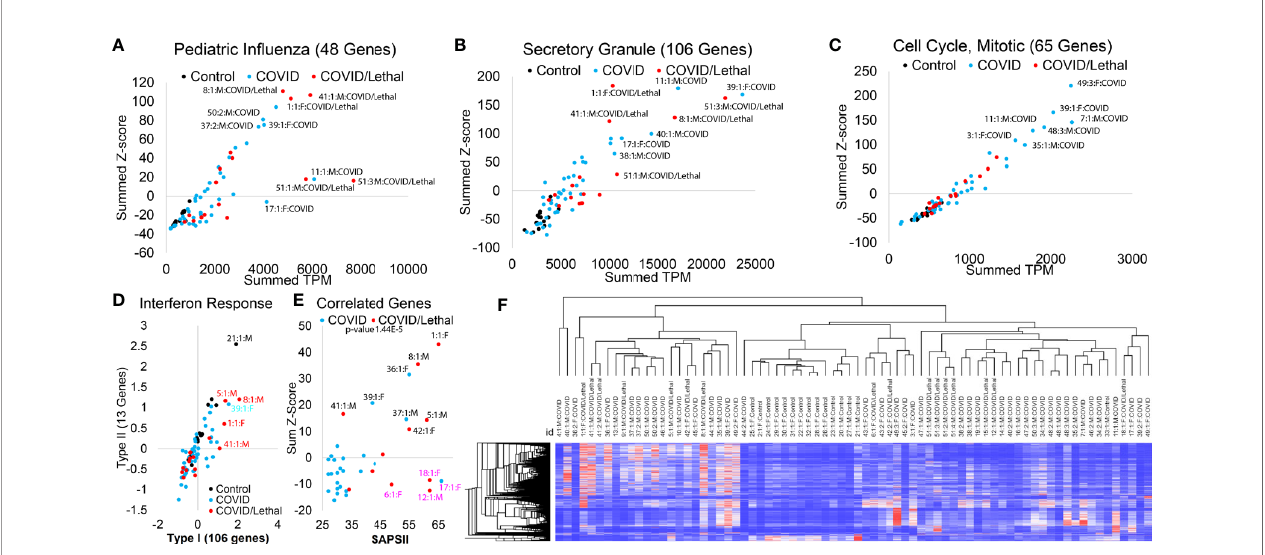
FIGURE 4 | Blood transcriptome gene panel signatures of SARS-CoV-2 patients. (A – C) Enriched associated genes for severe pediatric in fl uenza (A) , secretory granule (B) , and mitotic cell cycle (C) . The x-axis shows the added transcript per million (TPM) of all genes in the gene list, and the y-axis shows the added z-score for each group ’ s genes. Control samples are shown in black, COVID-19 patients in cyan, and COVID-19 patients deceased in red. The outlier samples are labeled (Sample #:collection #:Sex : Group). (D) Average Z-score for genes speci fi cally activated to Type I IFN (x-axis) or Type II IFN (y-axis). (E) The analysis of SAPSII (Simpli fi ed Acute Physiology) relative to combinations of genes that are correlated 0.5-0.4 to the SAPSII. (F) Heat map of the 770 signi fi cant genes in all samples. Clustering dendrogram of rows and columns is based on Spearman ’ s rank correlation.